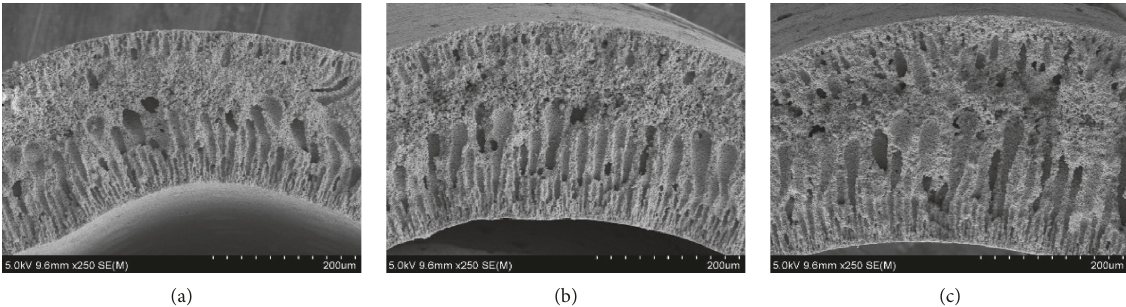
Figure 6: SEM images of titanium hollow-fiber adsorbents obtained at different inner-coagulating spinning velocities: (a) 1.25ml/min; (b) 2.50 ml/min; (c) 5.00ml/min.